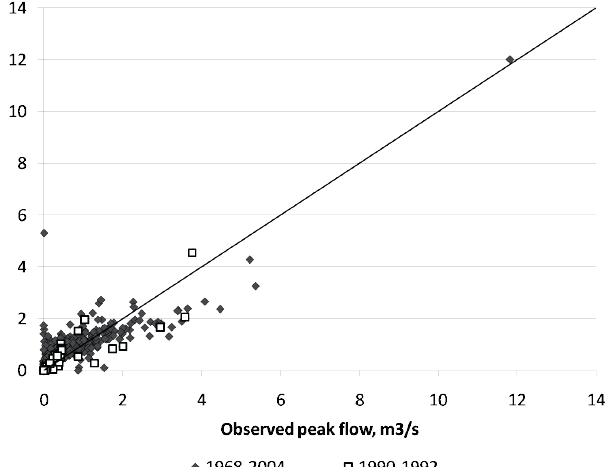
Fig. 3 Comparison between observed and simulated hourly peak floods for 24-hour rainfall events >20 mm for pre-and post-fire